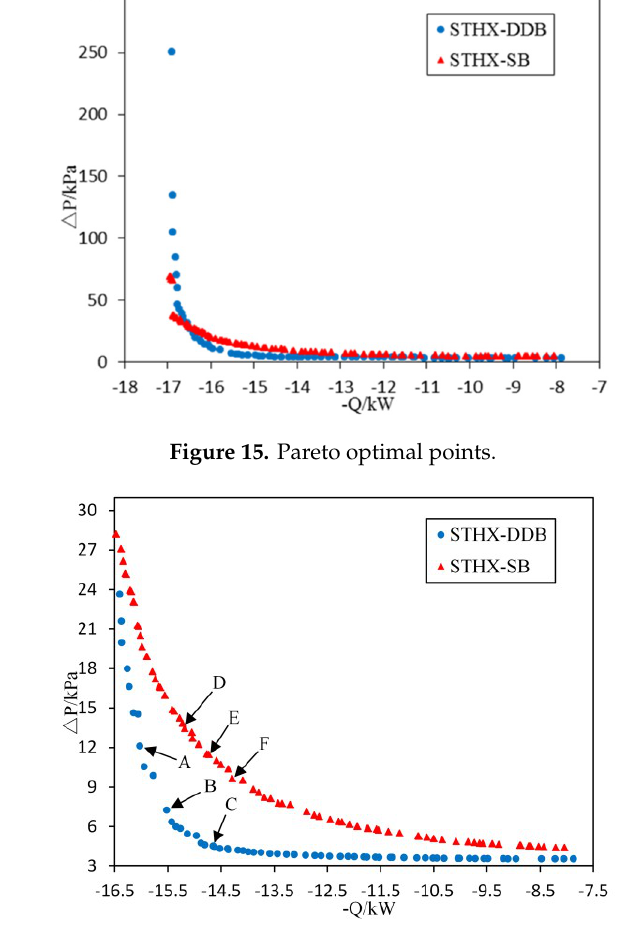
Figure 16. Pareto optimal points for the heat transfer capacity range of 7.5–16.5 kW.